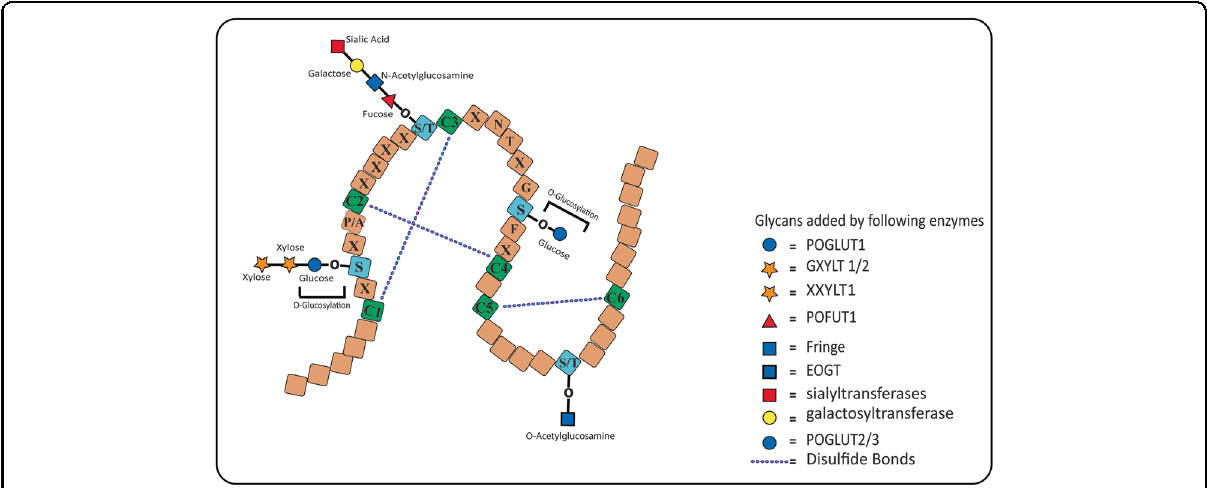
Fig. 4 EGF-like repeat in the NECD domain and its modi fi cations. Multiple EGF-like repeats present in the NECD harbor consensus sequences having a target site for glycosyltransferases. POGLUT1 adds O -Glc to a Ser residue in the consensus sequence C 1 -X-S-X-P/A-C 2 , which can further be extended to Xyl-Xyl-Glc-O trisaccharide by GXYLT1/2 and XXYLT1. The serine between C 1 and C 2 is highly conserved relative to other glycosylated sites, where both Ser and Thr can be found, and its the conformation of C 1 – C 2 motif because of which POGLUTs can not glucosylate the Thr residue. POGLUT2 and 3 glucosylate a Ser residue conserved in C 3 – C 4 of the EGF-like repeats and its further extension is not yet reported. POFUT1 adds O- Fuc to Ser/Thr residues between C 2 and C 3 of EGF repeats, which can further be elongated by Fringe enzyme. Moreover, the Ser/Thr residues between C 5 and C 6 is O- GlcNAcylated by a EOGT in Drosophila and